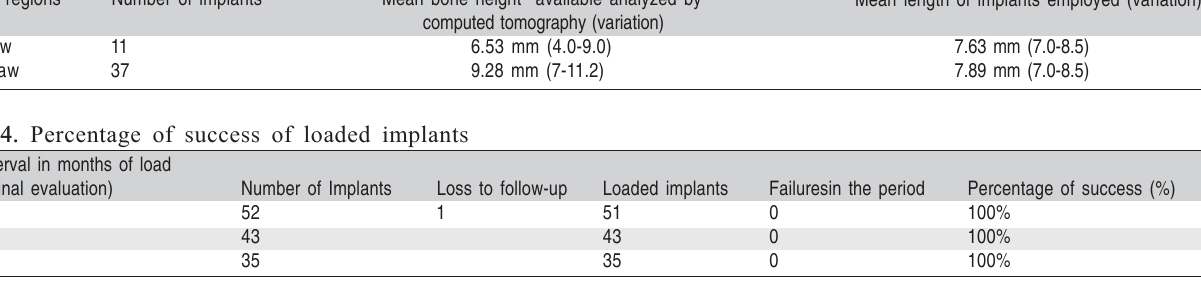
Table 3 . Mean bone height (mm) x length of implants (mm) on the 48 sites analyzed by computed tomography. Posterior regions